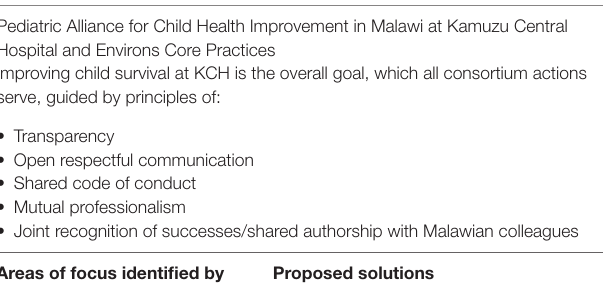
taBLe 1 | Key consortium practices and